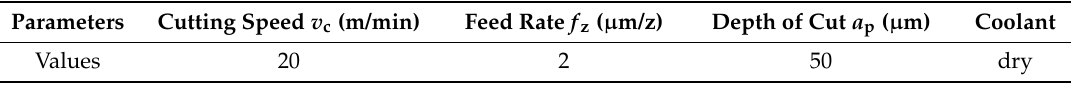
Table 3. Experiment cutting parameters.